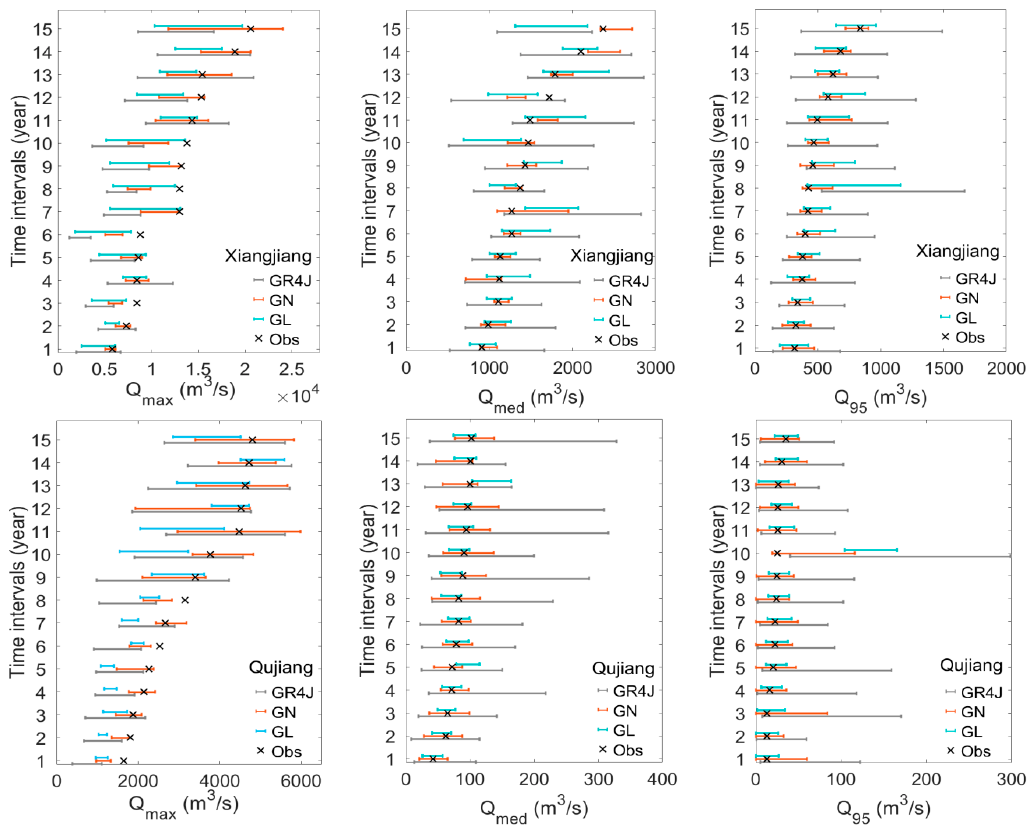
Figure 6. Uncertainty intervals of Qmax, Qmed, and Q95 in the years 1981–1995 for GR4J, GN, and GL in the Xiangjiang and Qujiang basins. Table 4. Average uncertainty intervals and cover ratios of Qmax, Qmed, and Q95 with GR4J, GN, and GL. River Basin